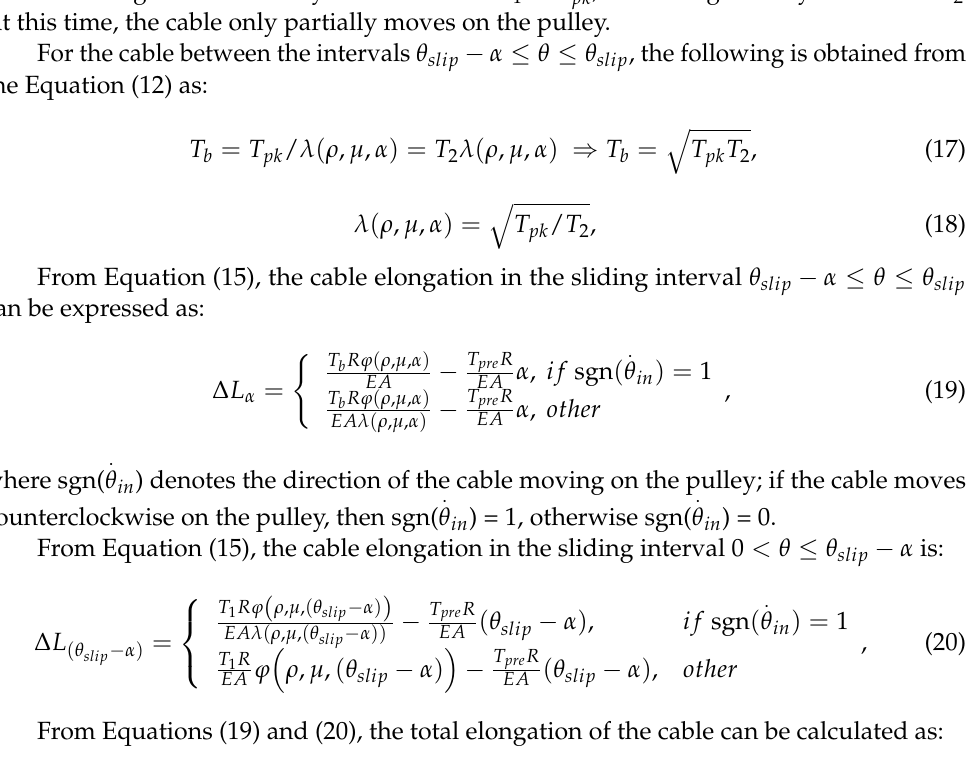
Figure 3b is the tension distribution diagram of the cable in the process of